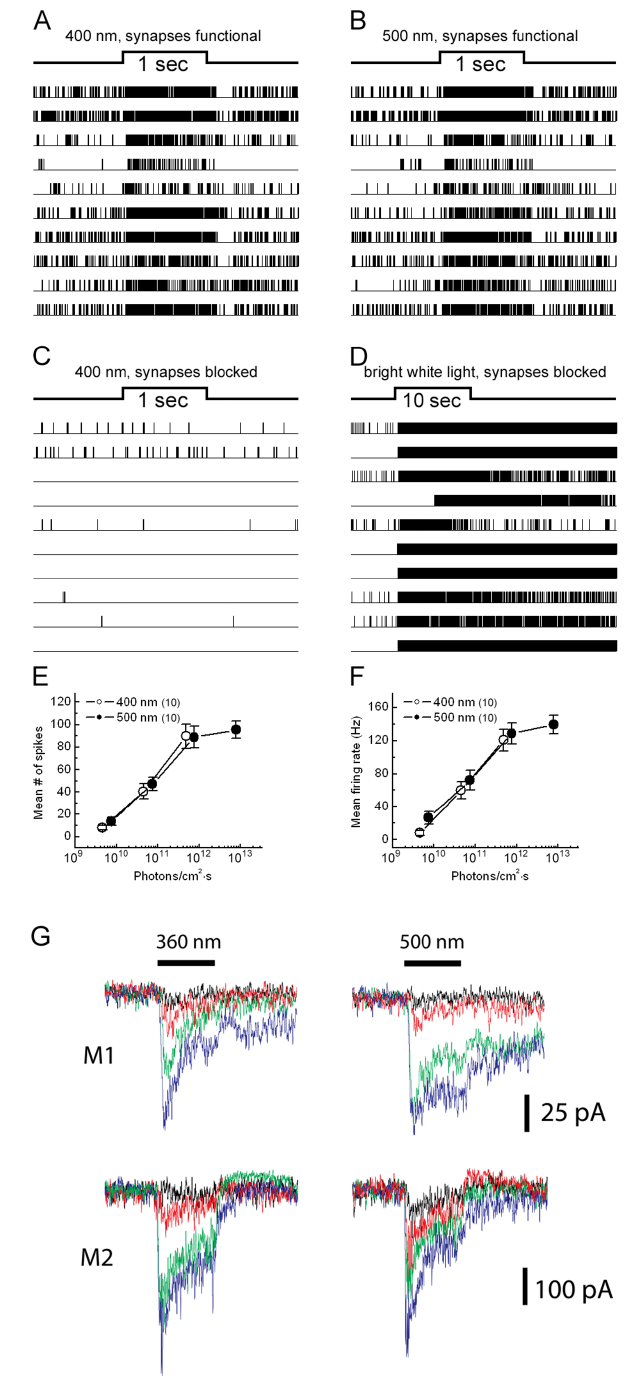
Figure 6. Evidence for ON channel input to ipRGCs from both M-cones and S-cones. A , B : Raster plots of responses to spectrally narrowband stimuli for ten ipRGCs recorded simultaneously in a Cx36 knockout mouse retina. These brisk ON responses were presumably exclusively cone-driven because Cx36 KO mice lack the primary and secondary rod ON pathways and because the flashes were subthreshold for activation by intrinsic melanopsin phototransduction. The response to a 400 nm stimulus (A) closely resembled that to a 500 nm stimulus (B), despite the fact that the former would be more effective in stimulating S-cones and the latter much more effective for M-cones. The two stimuli were approximately matched for photon flux density (400 nm: , 5 6 10 11 photons cm 2 2 s 2 1 ; 500 nm: , 7 6 10 11 photons cm 2